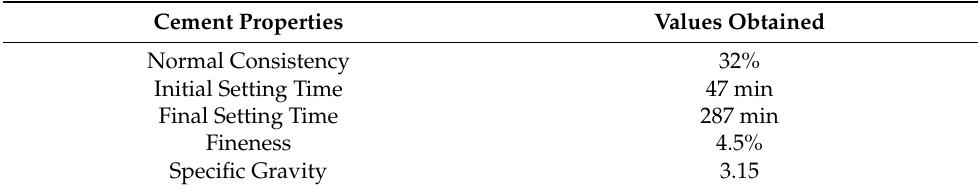
Table 1. Properties of